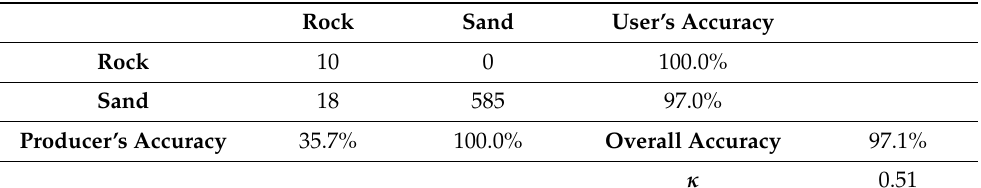
Table 4. Confusion matrix and user’s (row-wise) accuracy, producer’s (column-wise) accuracy, overall accuracy, and Cohen’s Kappa statistic ( κ ) for the substrate map of the Elbow of the west Florida shelf derived using unsupervised